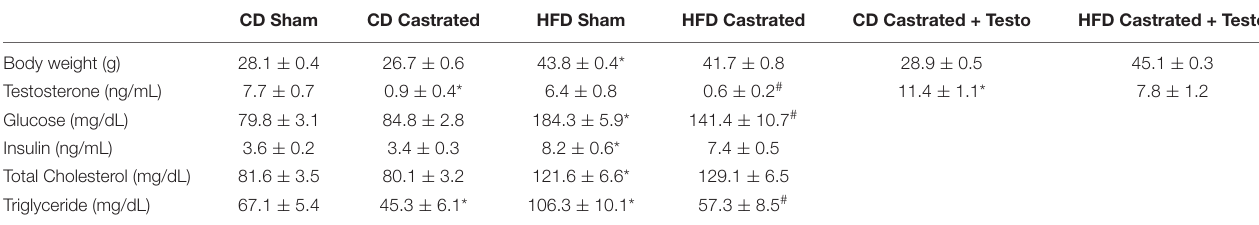
TABLE 1 | Body weight and biochemical profile in the experimental groups of mice.